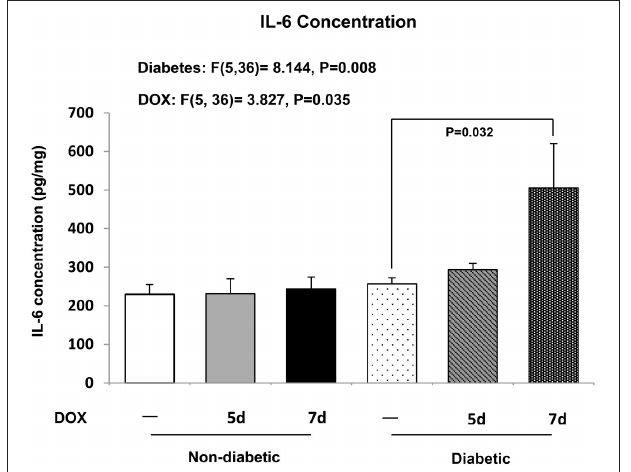
FIGURE 6 | Cardiac IL-6. Concentration of IL-6 in the hearts was examined. Data are expressed as mean ± SEM. According to our two-way ANOVA results, the significant main effects of the factor diabetes and DOX were found in IL-6 concentration (Diabetes effect: P = 0.008, F = 8.144; DOX effect: P = 0.035, F = 3.827). Individual means were compared among groups by one-way ANOVA with Turkey’s HSD post-hoc